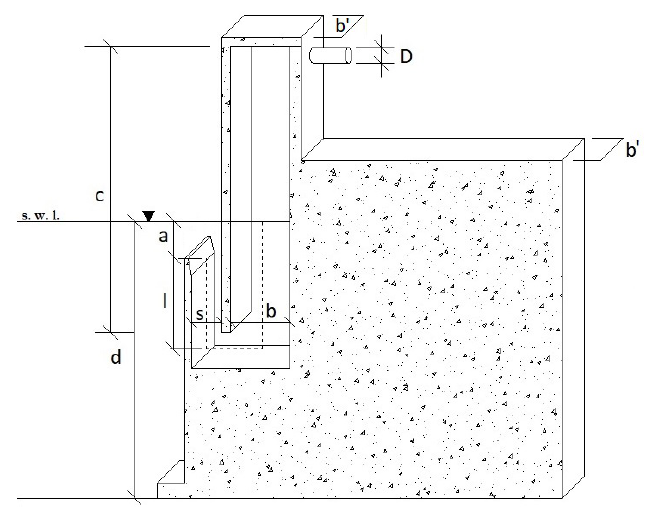
Figure 1. Vertical cross section of the caisson breakwater installed at Civitavecchia’s harbour. Design adapted from